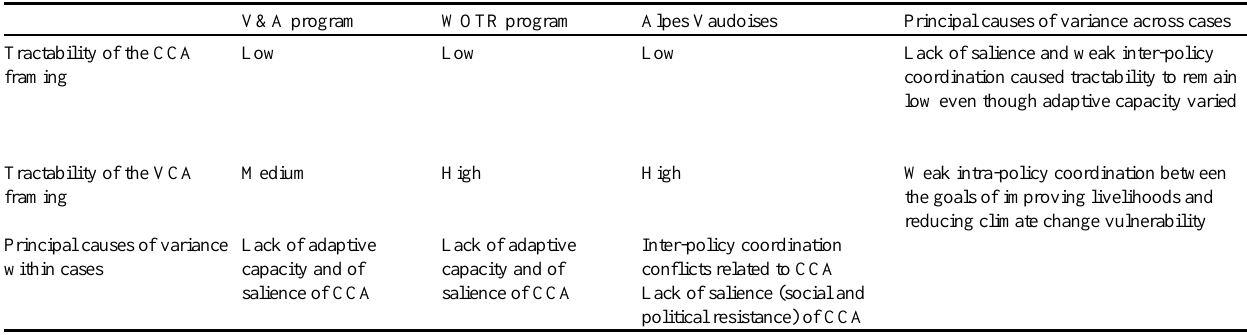
Table 6. Tractability of adaptation framings within and across